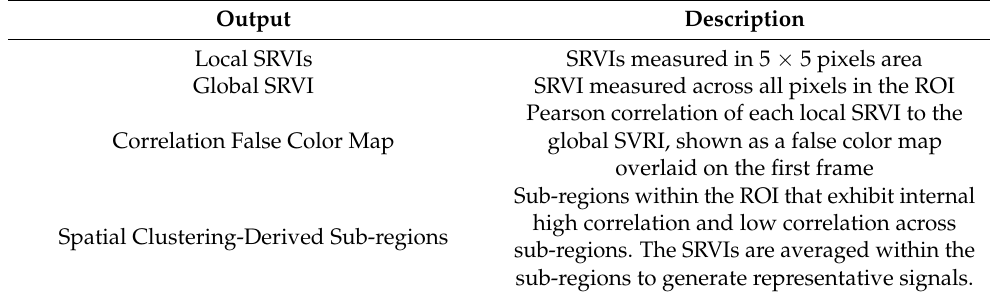
Table 1. Data analysis